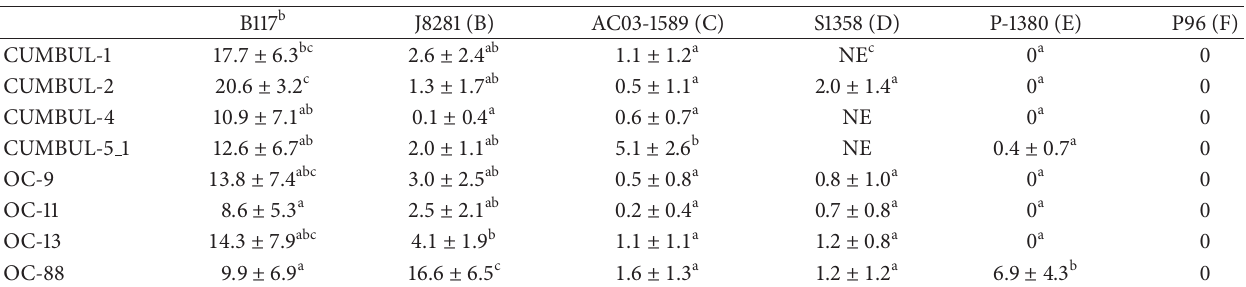
Table 6: Number of emerged Orobanche cumana shoots per sunflower plant (mean ± standard deviation) in the evaluation of O. cumana populations CUMBUL-1, CUMBUL-2, and CUMBUL-4, collected in Bulgaria on Artemisia maritima , CUMBUL-5 1, collected in Bulgaria on Anthemis arvensis , OC-9, OC-11, and OC-13, collected in Bulgaria on cultivated sunflower, and OC-88, collected in Spain on cultivated sunflower, on six sunflower lines with different levels of genetic resistance, conducted in pots in 2008 a . The O. cumana race to which each sunflower line is expected to be resistant (if any) is given in parenthesis. B117